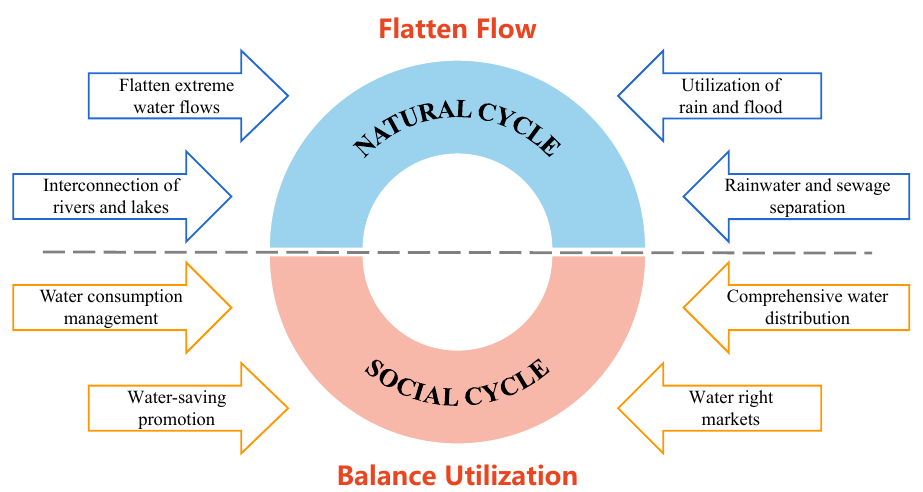
Figure 4. The mechanisms of the Virtuous Cycle.